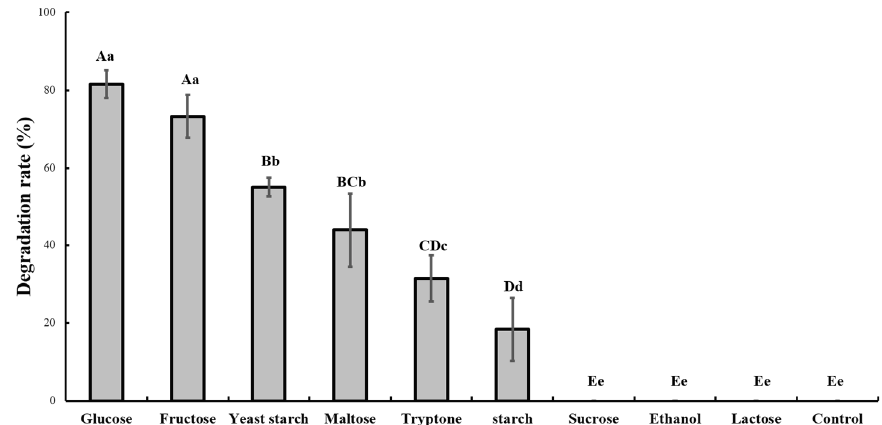
Figure 2. E ff ect of di ff erent carbon sources (1 g / L) on the degradation of 50 mg / L chlorantraniliprole (CAP) by strain GW13. The degrading amount of CAP was measured after incubation in 25 ◦ C and pH 7 for 24 h. The data are represented as the mean ± standard deviation (SD) for triplicate incubations. Di ff erent letters above the bars indicate significant di ff erences among di ff erent treatments at p < 0.05 (uppercase) or p < 0.01 (lowercase) (one-way analysis of variance, ANOVA, and Dunnett’s test). The optimal pH and temperature for CAP degradation were tested in the batch experiment, and ◦ the results showed that pH 7.0 and 28 C were the optimal conditions (Figures 3 and 4).